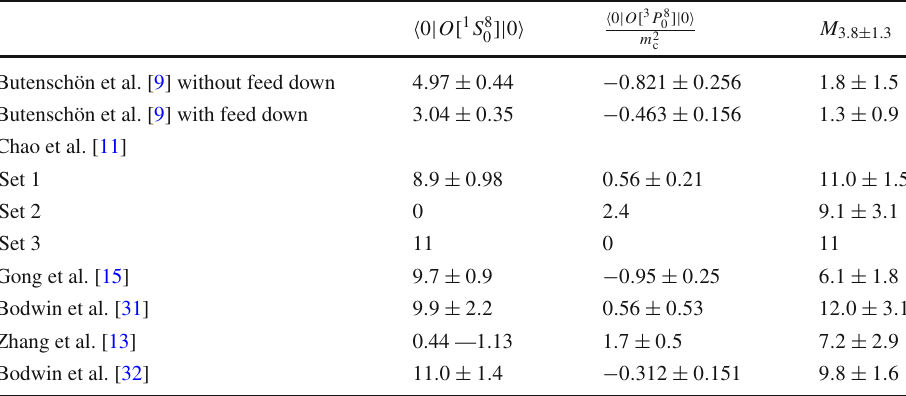
Table 1 The LDMEs for J /ψ production extracted from the J /ψ/η c hadronic production through six works in units of 10 − 2 GeV 3